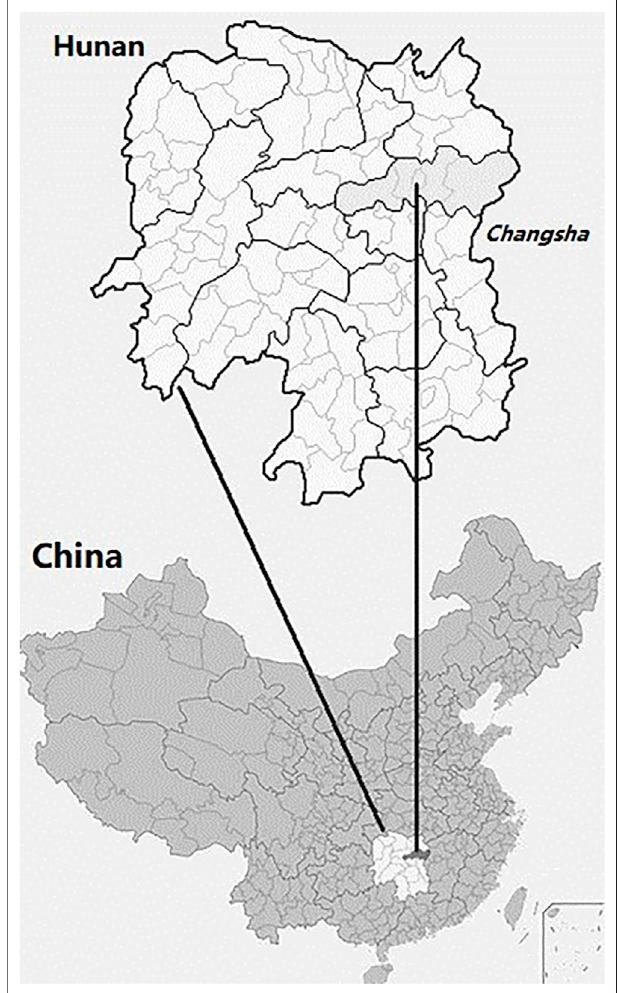
FIGURE 1 | Location of the study area, Hunan Botanical Garden in Changsha city, Hunan Province,